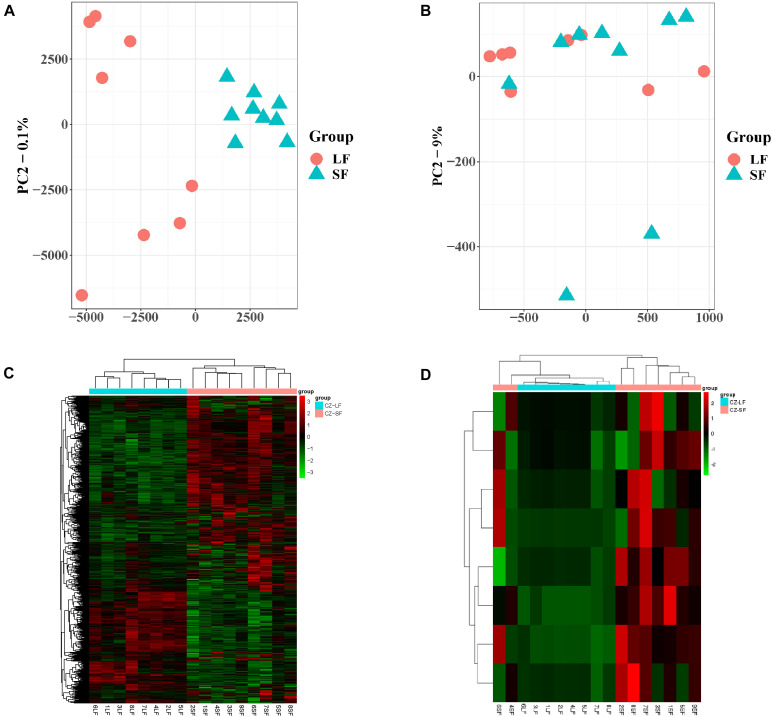
Expression analysis of mRNAs and lncRNAs. (A) PCA analysis of mRNA expression with FPKM. (B) PCA analysis of lncRNA expression with FPKM. (C) Clustering analysis showing the expression profiles of DEmRNAs between SF and LF groups. (D) Clustering analysis showing the expression profiles of DElncRNAs between SF and LF groups.